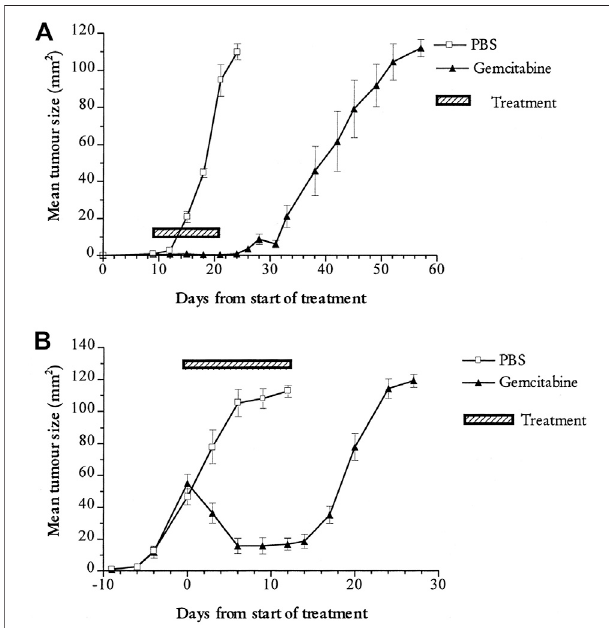
FIGURE 1 | Preclinical evidence of effectiveness of chemotherapy in mesothelioma. The apoptosis-inducing chemotherapy agent gemcitabine (blacktriangles)induces invivo regressionofthemousemesotheliomatumour line AB1-HA compared to mice treated with phosphate buffered saline alone (open squares) (A) Early treatment; tumour bearing mice were treated whentumoursweresmall(~10 mm 2 ) (B) Latetreatment.tumourbearingmice weretreatedwhentumoursweresmall(~10 mm 2 ).Miceweretreatedwith fi ve doses of gemcitabine or PBS injection at third daily intervals. Figure originally published in Nowak et al., 2002a. Cancer Research 62:2353-8.